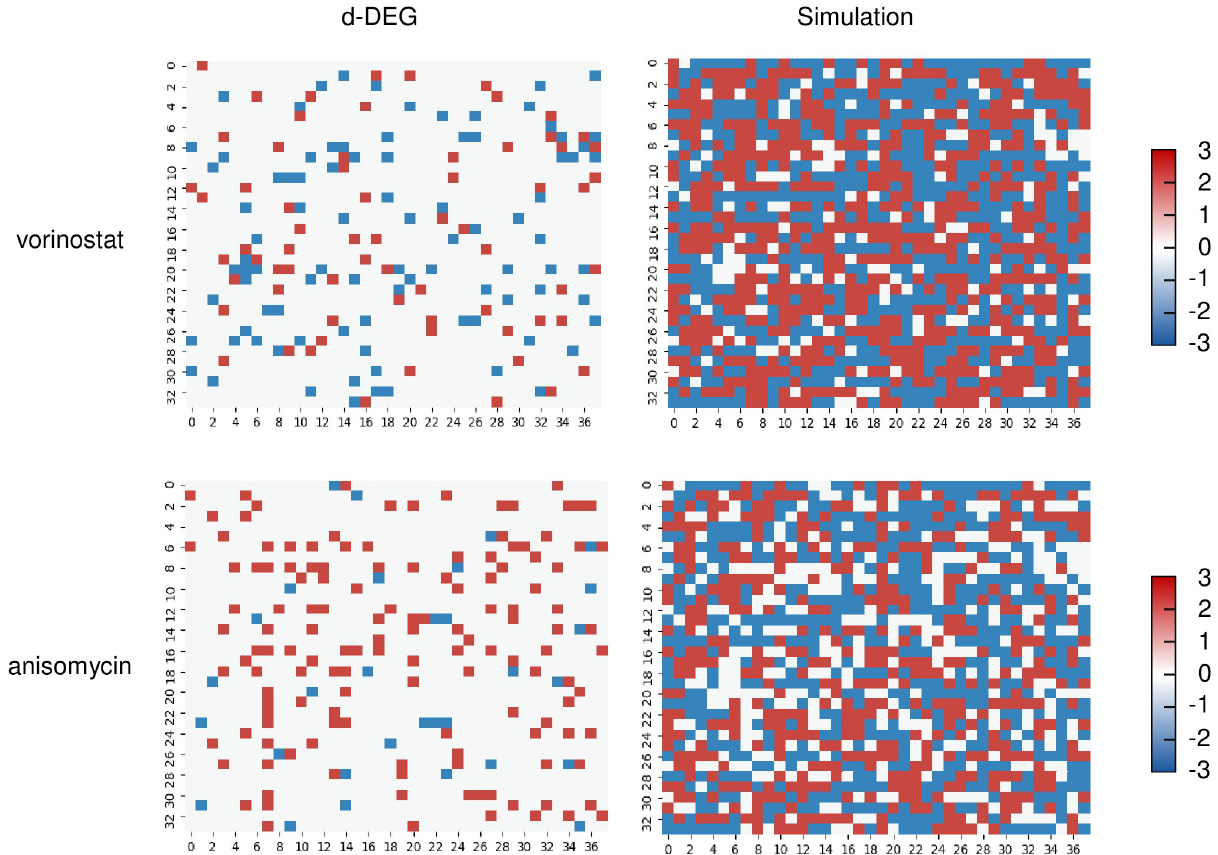
Fig 3. Simulation of drugs applied to aged samples. Original DEG pattern of the aged group. The drug-induced DEGs (d-DEGs) of vorinostat and simulated effects when applied to o-DEGs. The d-DEGs of anisomycin and simulated combination effects with vorinostat.